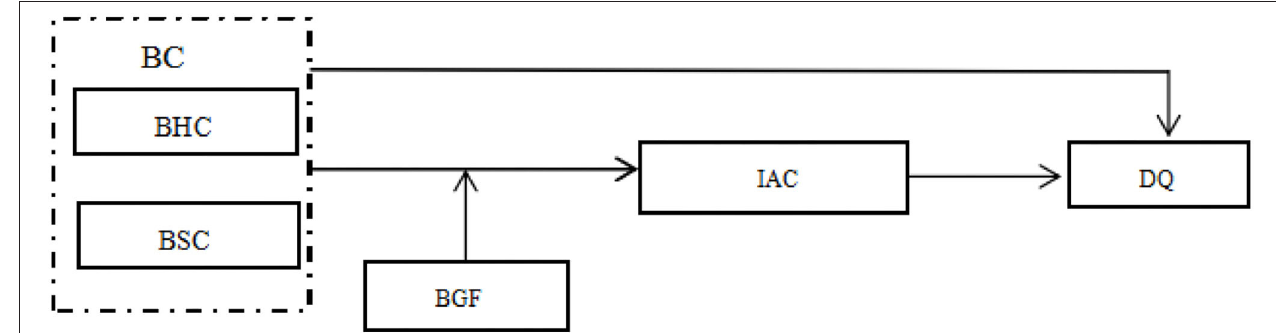
FIGURE 1 | The conceptual